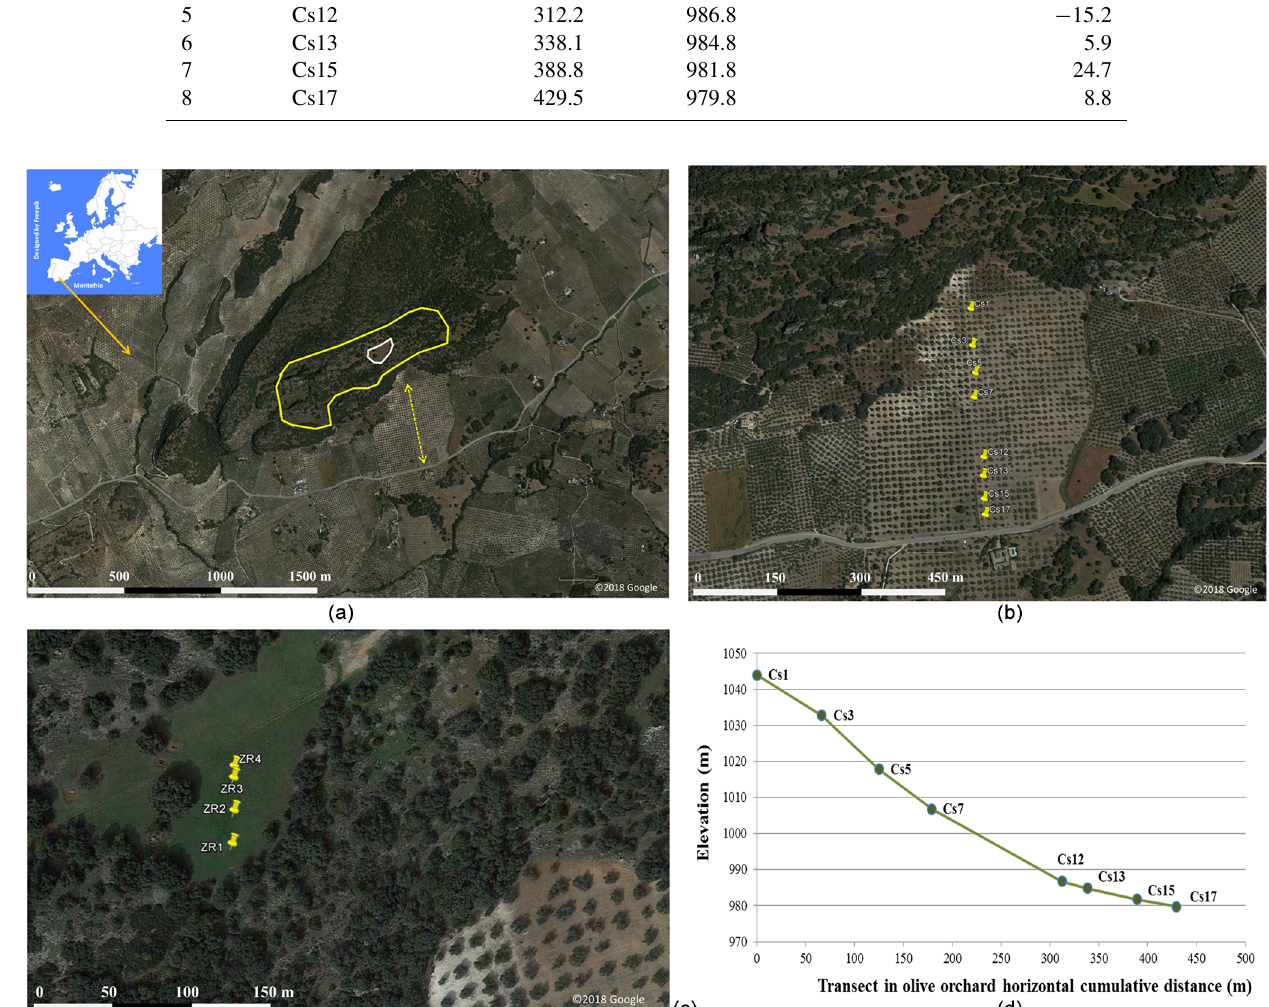
Figure 1. Site location and associated sampling scheme. (a, b, c) Location map of the sampling area in Montefrío, southern Spain. Reference site delineated by the white line within a protected archeological site (yellow line). Yellow markers in (b) indicate the sampled transect within the olive orchard. Numbering starts in the points at higher elevation; see (d) for the elevation change in the transect in the orchard. Yellow markers in (c) indicate sampling point in the reference area. The map of Europe was designed by Freepik, and the aerial images are taken from Google Earth (© Google Earth